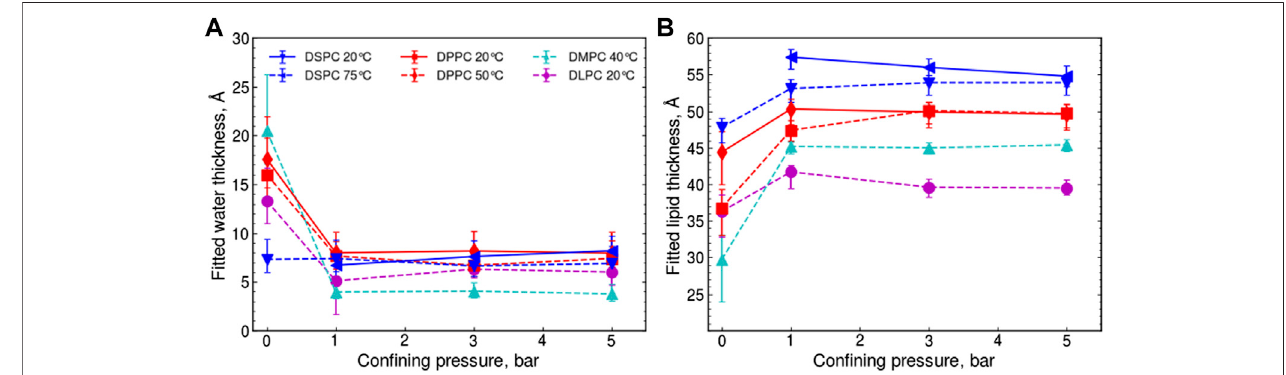
FIGURE3| Trendsofthe fi tted (A) waterlayerthicknessand (B) lipidlayerthicknessinthelipidbilayerstacks,hydrated withD 2 Ovapor,takenfromthebestmodel fi ts. Lines are to guide the eye only and the symbols de fi ne data for the same samples in both (A) and (B) . Uncertainties are derived from fi tting the data with two